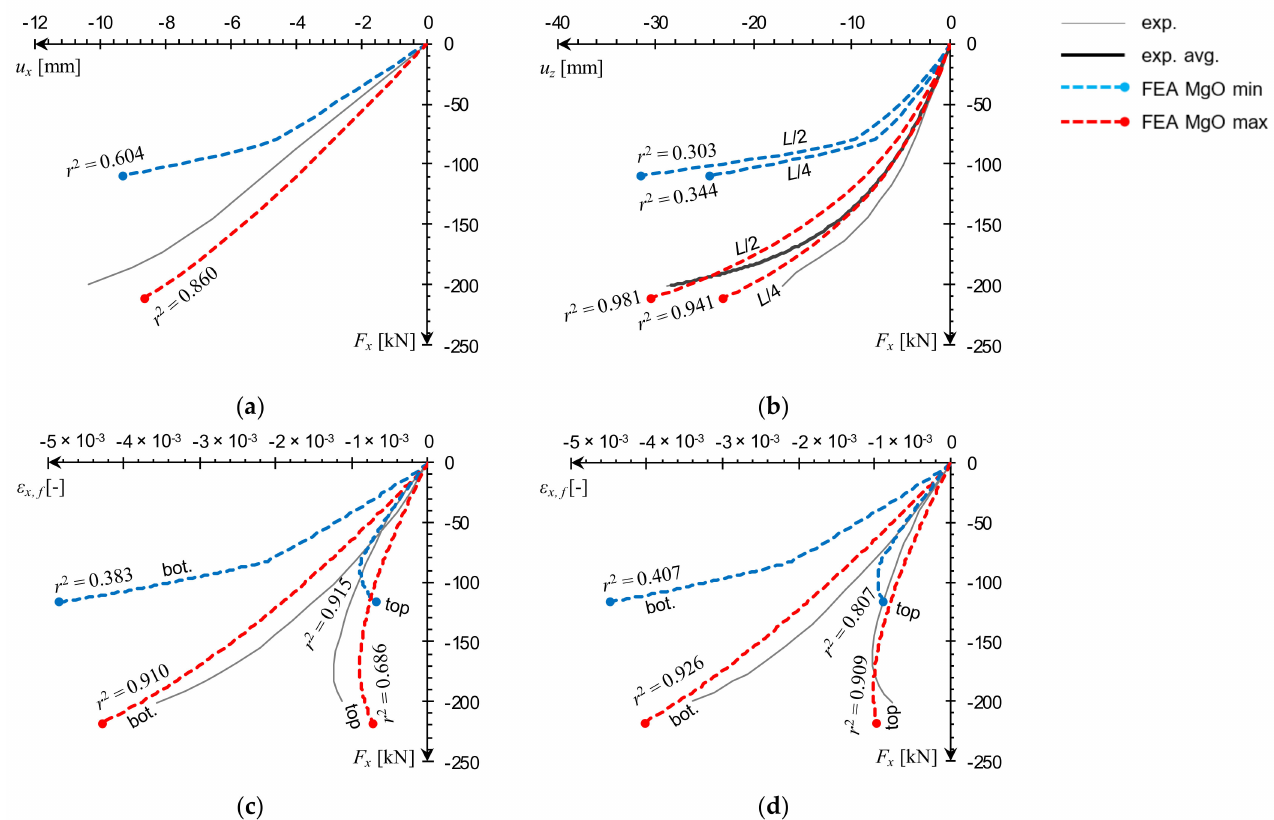
Figure 18. Comparison of natural-scale e1 panel compression test curves obtained from FEA against experimental